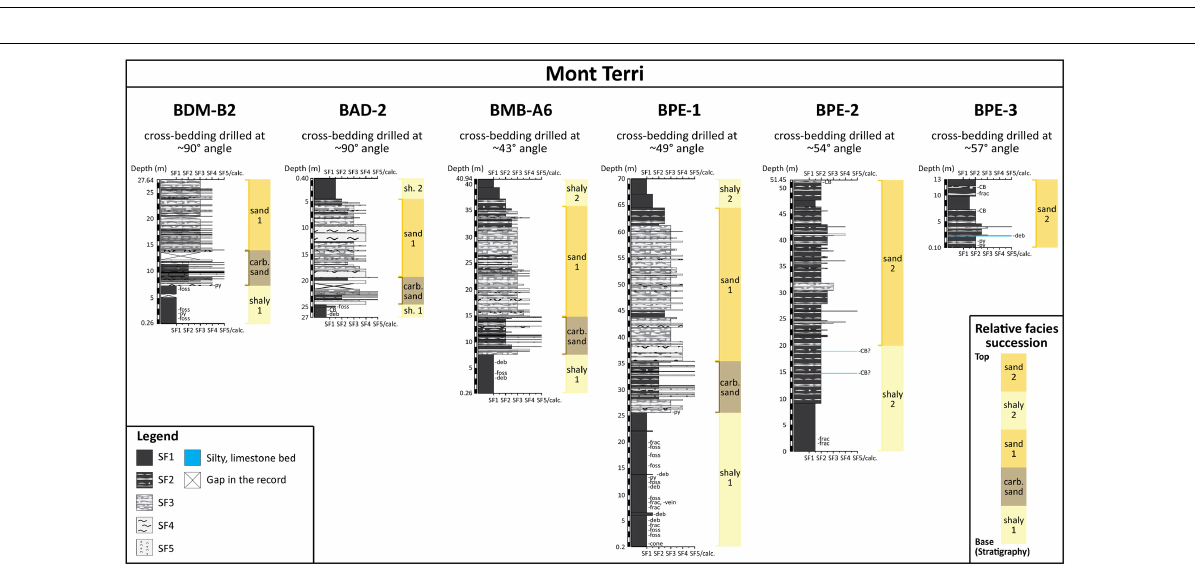
Frontiers in Earth Science |